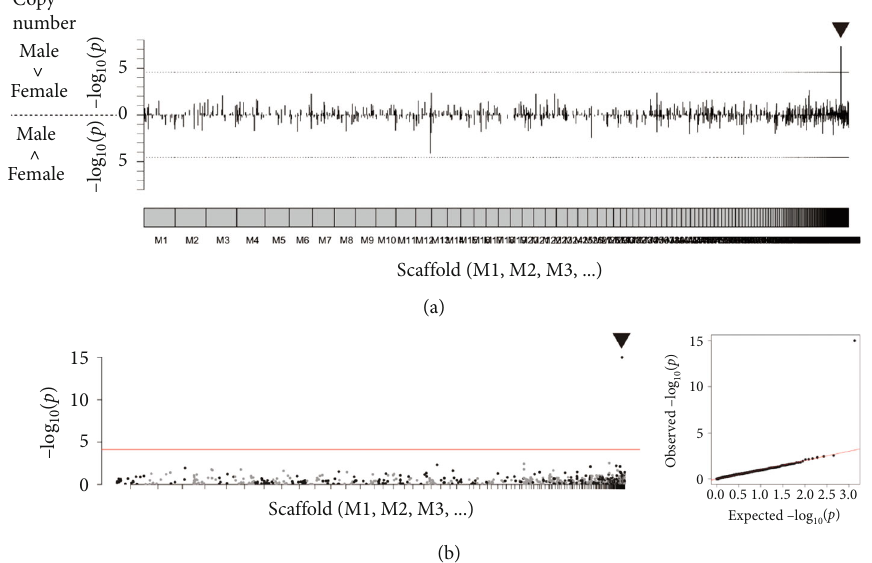
in the female genome. F64